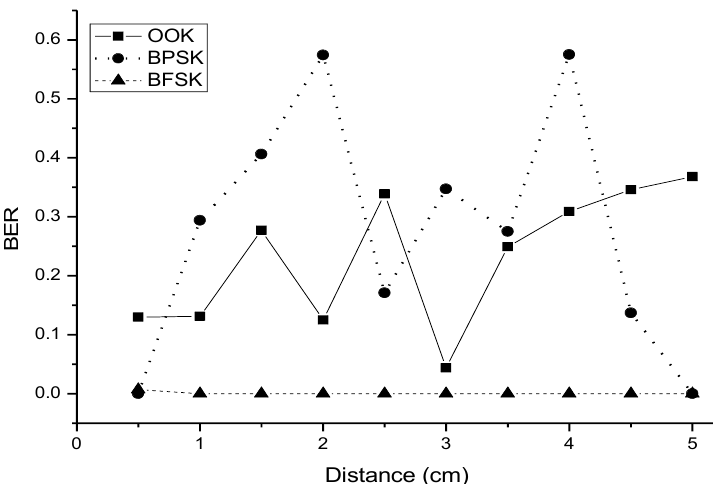
Figure 11. Bit error rate over different transmission ranges for the three modulation schemes in the experimental results.